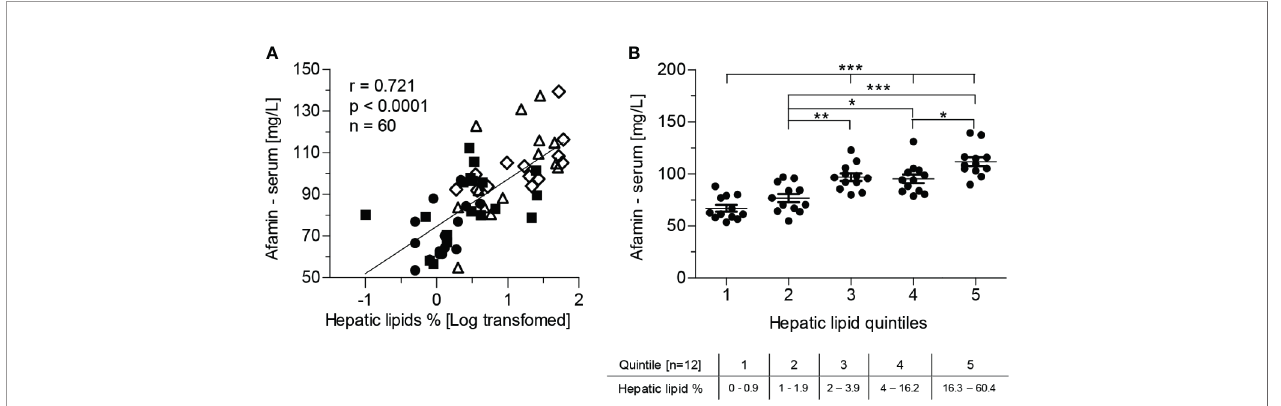
FIGURE 2 | Serum afamin concentrations and hepatic lipid content, measured by 1 H-MR spectroscopy (study 1). (A) Serum afamin correlates positively with hepatic lipids (Pearson linear correlation) (B) Strati fi cation of the study population into quintiles according to hepatic lipid content. Data are presented as mean ± SEM. *p < 0.05; **p < 0.01; ***p < 0.001; 1-way ANOVA followed by Tukey post-hoc test; lean-healthy; ■ obese-healthy; D obese -prediabetes, obese - type 2 diabetes.